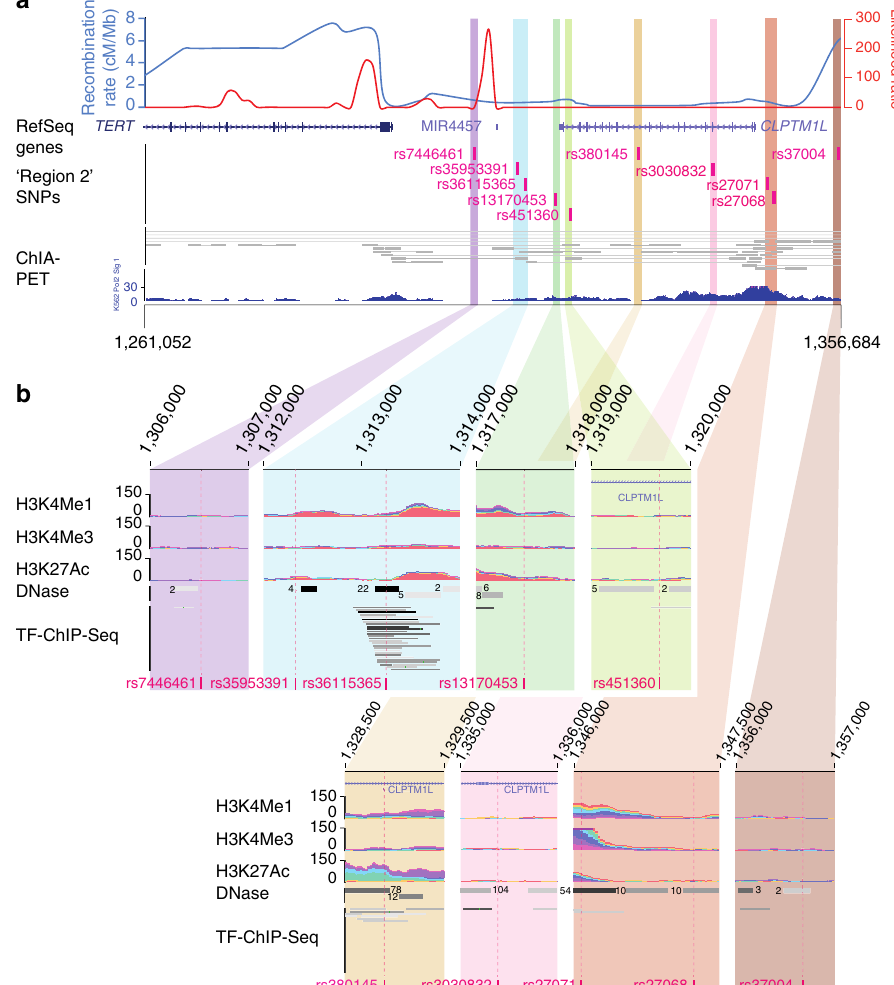
Figure 1 | Map of TERT and CLPTM1L region. Recombination hotspots in the CEU population (red line), as well as 1000G combined recombination rate (blue line) across the TERT / CLPTM1L region are shown relative to the CLPTM1L and TERT genes, as well as the grouping of ten highly correlated sequence variants strongly associated with risk of pancreatic, testicular, and lung cancers in the region closest to CLPTM1L . ( a ) Chromatin interaction analysis paired-end (ChIA-PET) sequencing data from the K562 chronic myeloid leukaemia cell line using an antibody against RNA polymerase II generated by the ENCODE project (https://www.encodeproject.org/) is shown. For each of the ten strongly associated variants, layered H3K4Me1, H3K4Me3, and H3K27Ac chromatin immunoprecipiation (ChIP-seq), DNAse I hypersensitivity sequencing (DNase) and transcription factor ChIP-seq (TF-ChIP-Seq) data from the ENCODE project are shown ( b ) as displayed by the UCSC Genome Browser (lower panels). NATURE COMMUNICATIONS|8:15034|DOI: